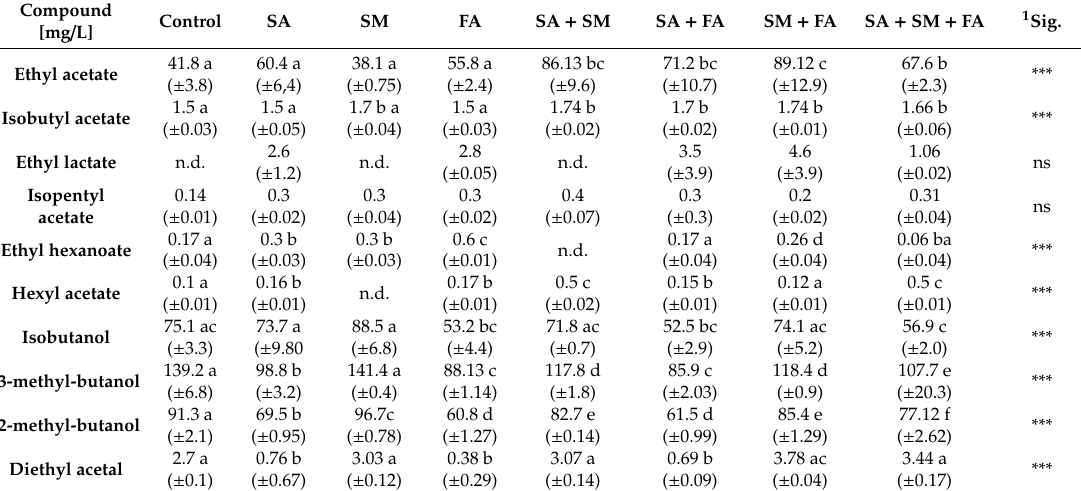
Table 11. Volatile compounds in ciders fermented by wild (D) yeast, with the following additions: SA—ammonium sulfate, SM—magnesium sulfate, FA—ammonium phosphate.